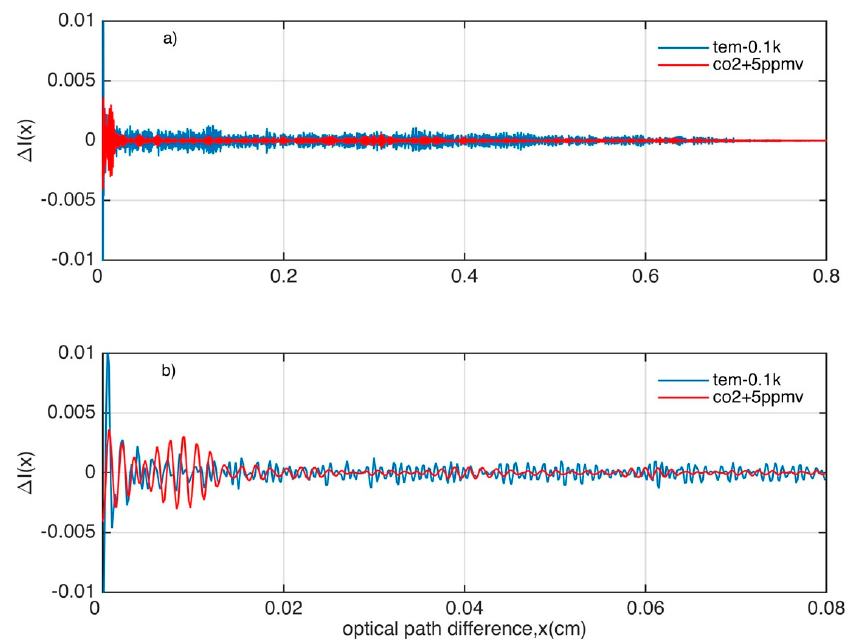
Figure 7. The ISDs caused by temperature perturbation of 0.1 K and CO 2 perturbation of 5 ppmv, respectively. The interferograms are converted from the radiance spectra with 0.625 cm − 1 spectral resolution from 600 to 2600 cm − 1 spectral region. ( a ) shows the ISD for the entire interferogram in regard with original spectral resolution; ( b ) illustrates the first one-tenth of the interferogram di ff erence in ( a